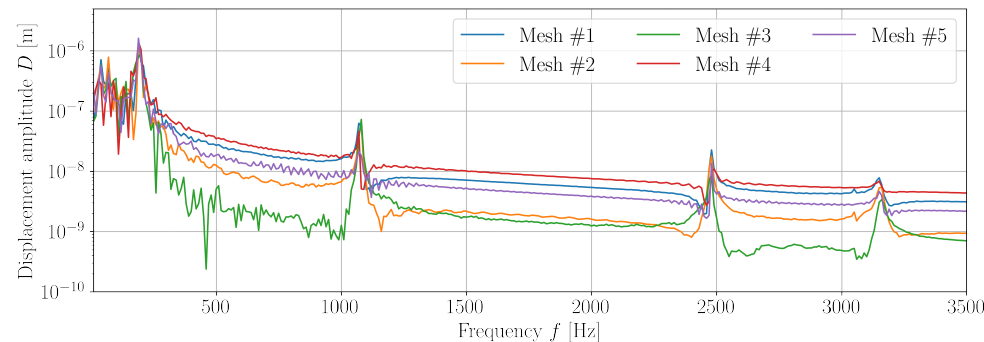
Figure 5. Spectrum of displacement along y axis at probe S3 for finite volume mesh indepen- dence study.